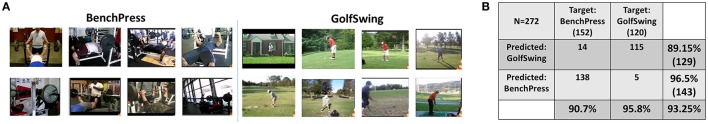
(A) Clips of the 8 training videos for each class (BenchPress/GolfSwing) incorporating multiple views/variation in action signature. (B) Confusion matrix showing the overall as well as class-wise accuracy for 2-class BenchPress/GolfSwing classification.